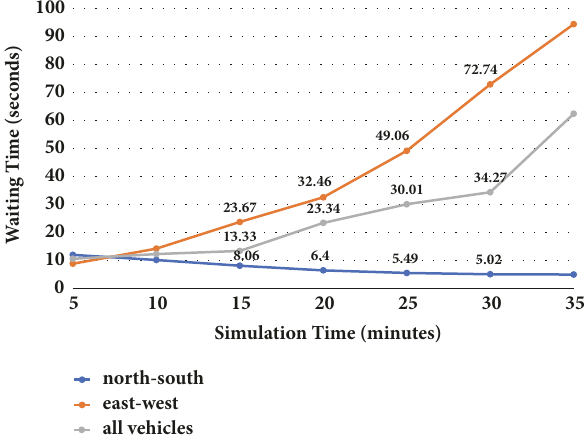
Figure 6: The system performance under adversary vehicles.